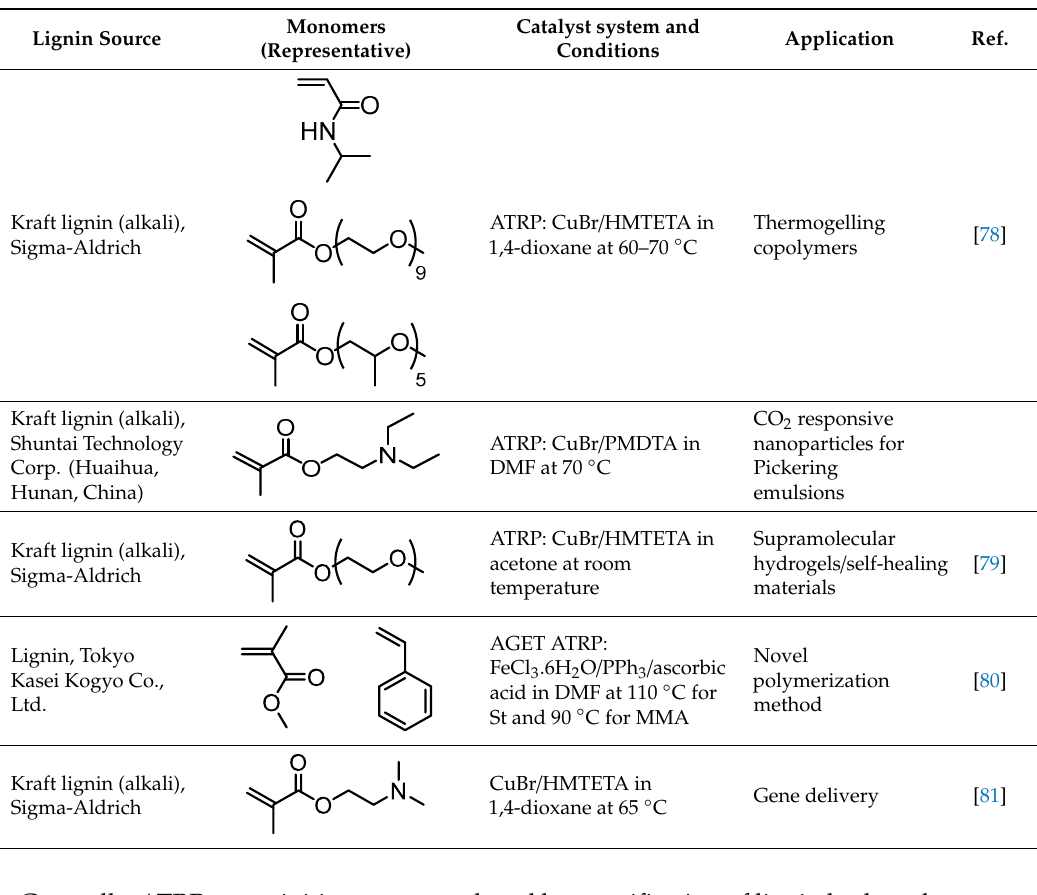
Figure 20. Preparation of lignin – g – polyNIPAM copolymers. Reproduced with permission [72].